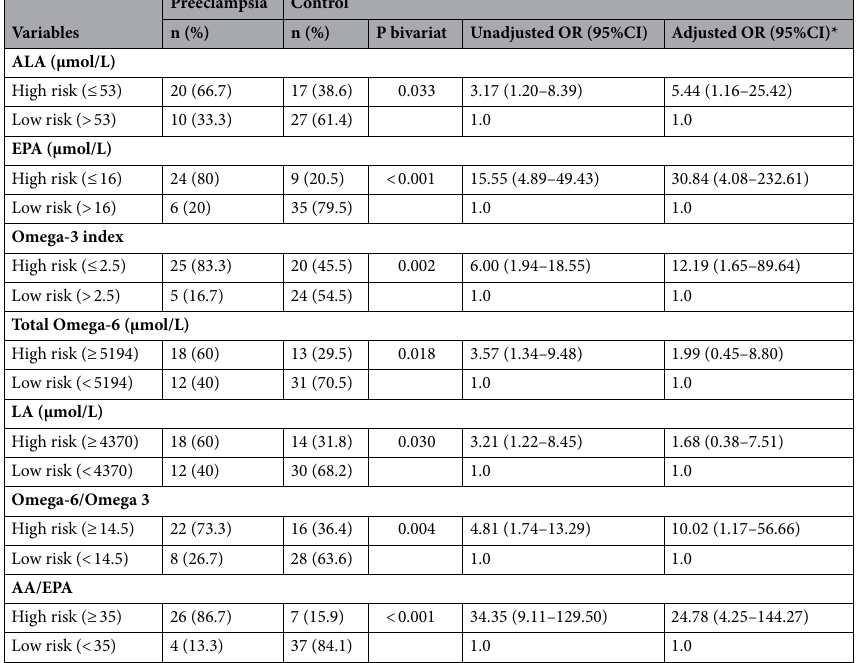
Table 5. LCPUFA parameters showing the risk of preeclampsia. * Adjusted for covariates: Maternal age, Gestational age, and Maternal pre-pregnancy BMI. 1.0: Reference